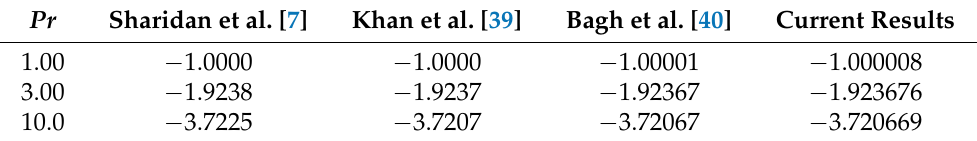
Table 3. Comparison of θ (cid:48) ( 0 ) via growing values of Pr when λ = Ω = α = a = M =